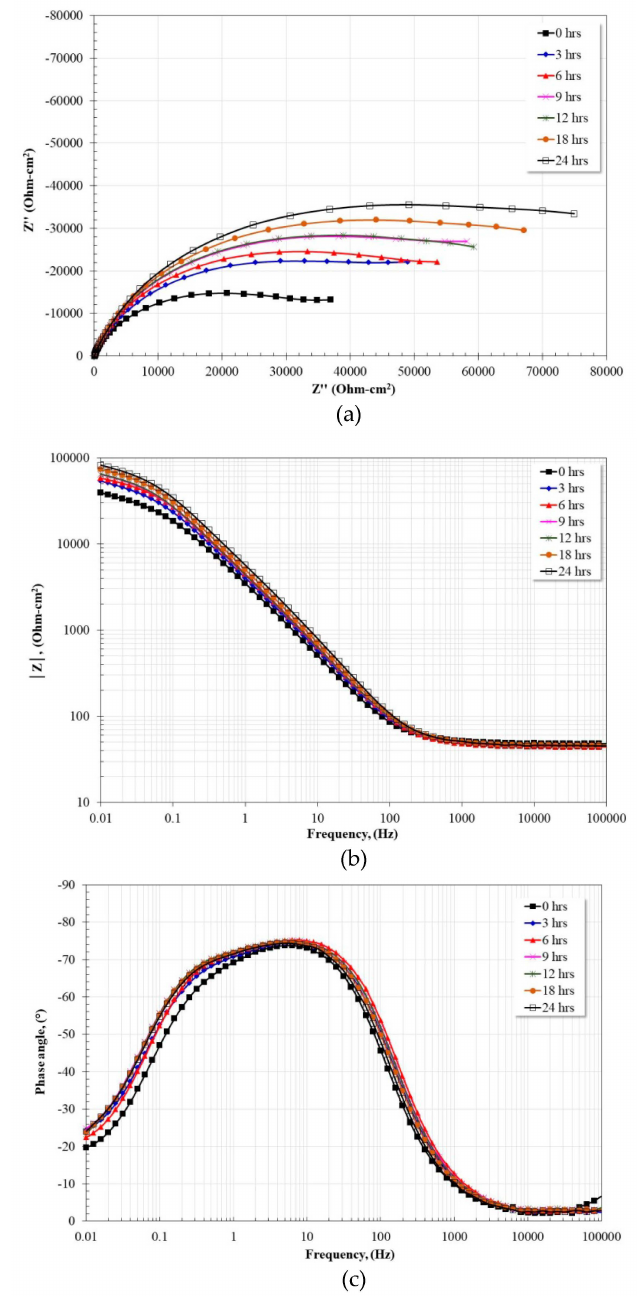
Figure 6. Nyquist ( a ) and Bode ( b , c ) plots for Ti exposed in artificial saliva at 37 ◦ C after 24